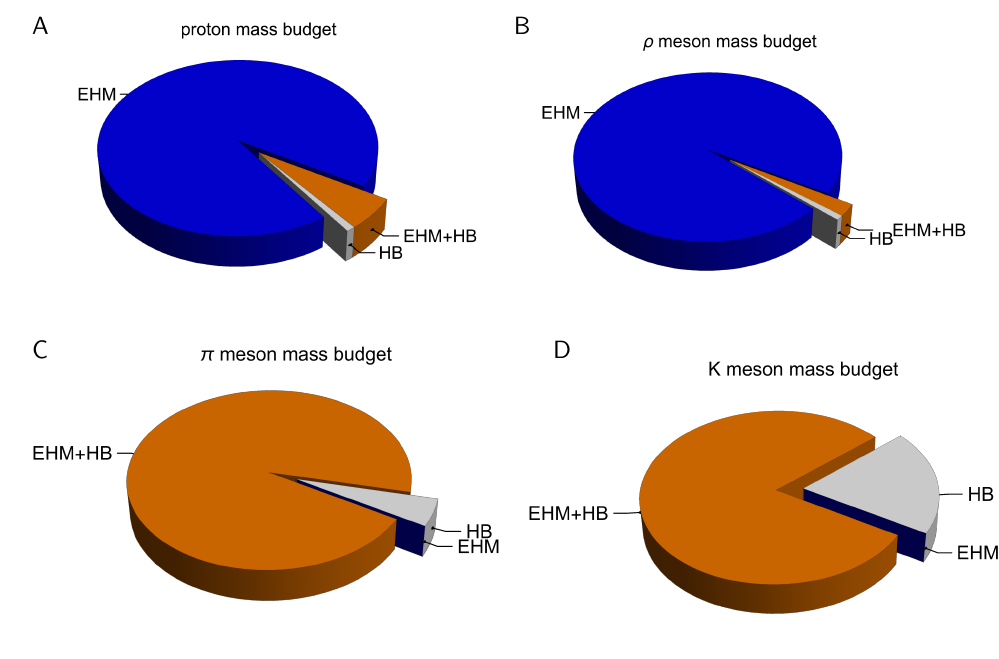
Figure 1. Mass budgets: ( A ) proton; ( B ) ρ -meson; ( C ) pion; ( D ) kaon. Each is drawn using a Poincaré-invariant decomposition and the numerical values listed in Table 1 (separation at ζ = 2 GeV , calculated using information from